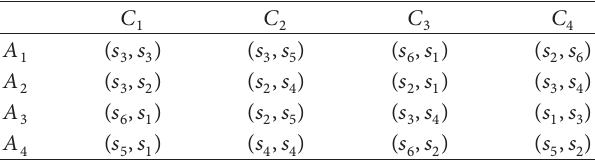
Table 3: The decision matrix 𝑅 3 given by 𝐷 3 .